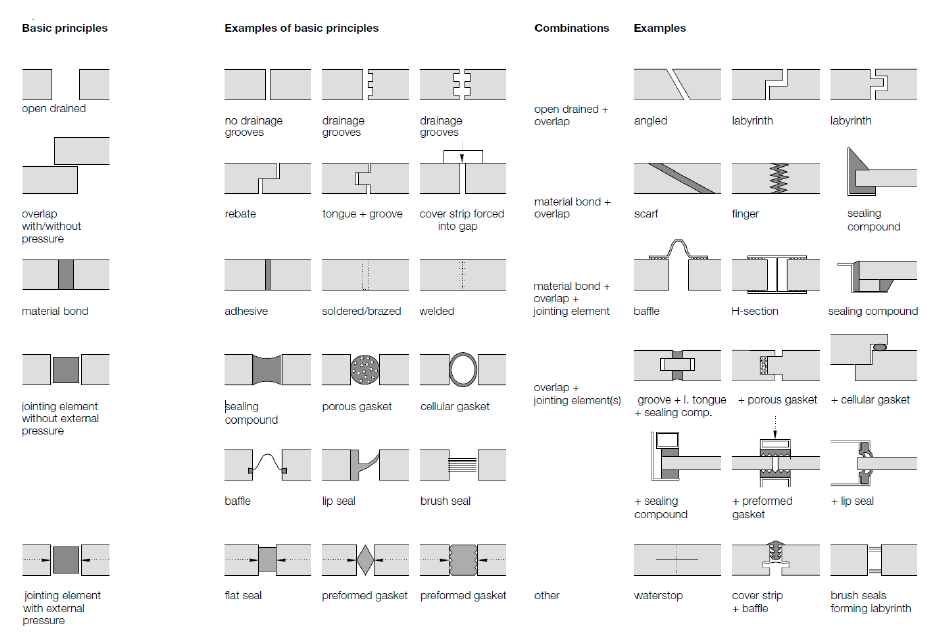
Figure 7. Schematic of Joint sealing principles [32].